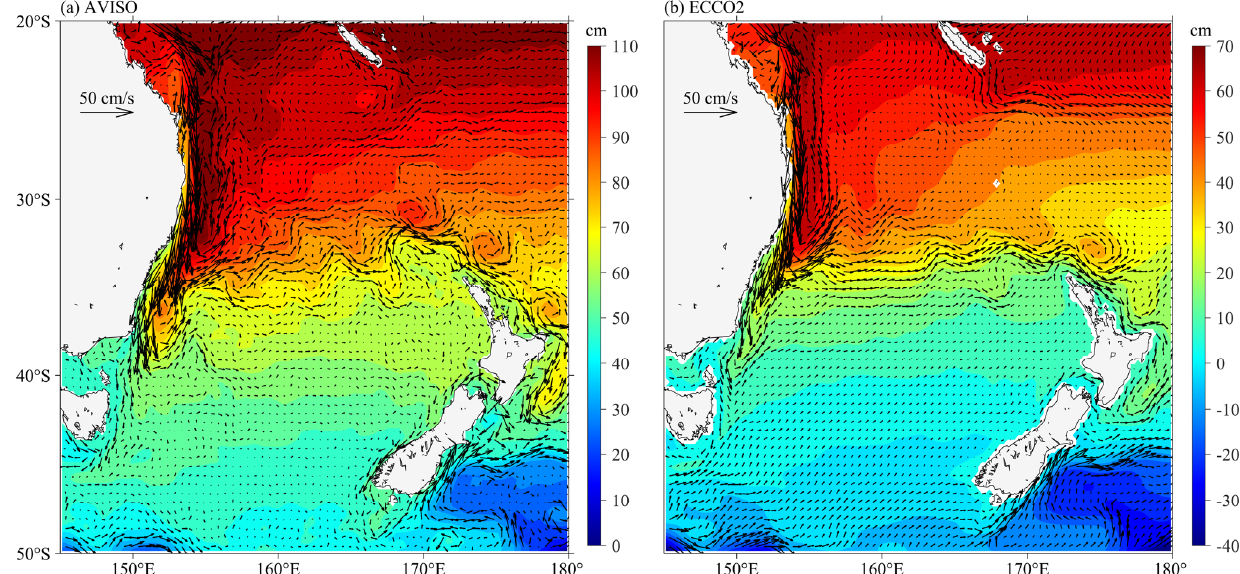
Figure 1. Climatology absolute dynamic topography (ADT, colors) and surface velocities (black arrows) in the western Pacific from ( a ) AVISO data and ( b ) ECCO2 state estimate outputs. Both results are averaged between January 1993 and October 2019.